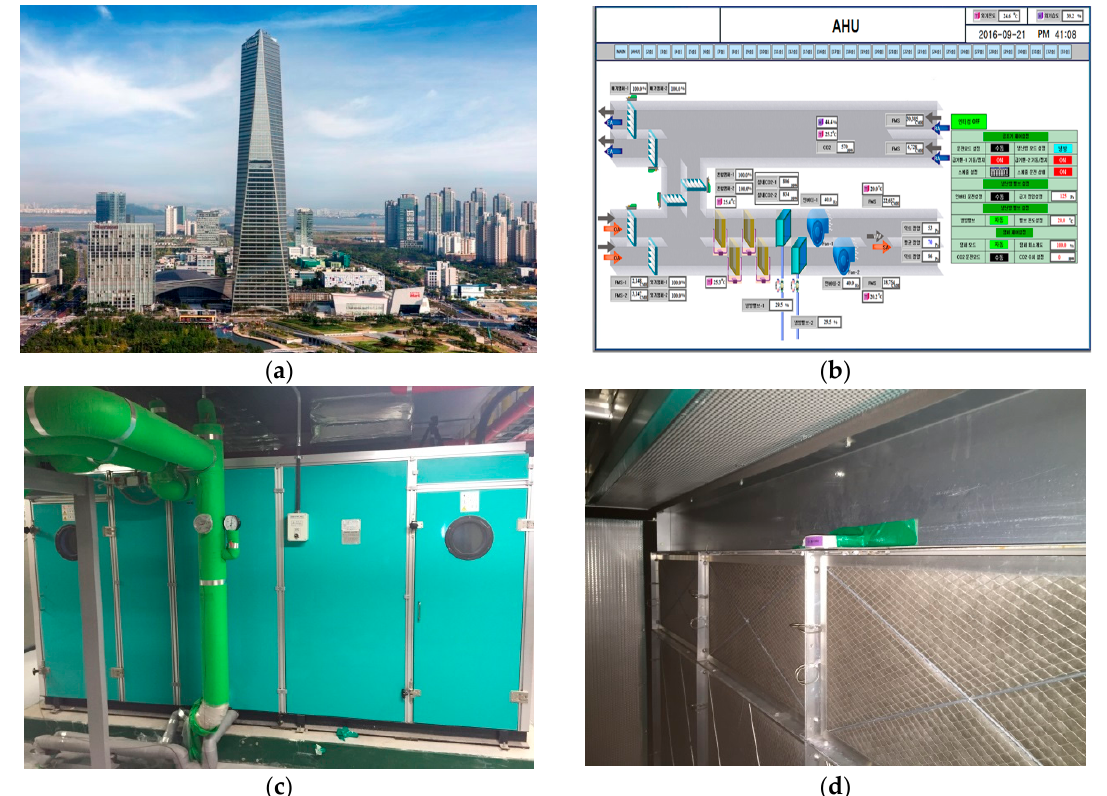
Figure 1. Outdoor air intake ratio according to the outdoor air temperature.